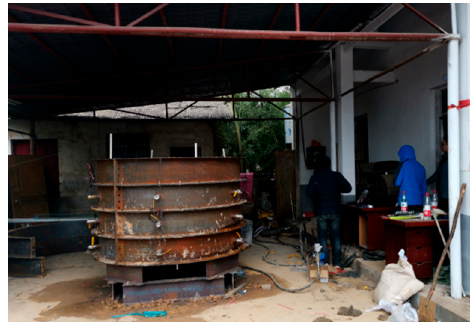
Figure 3. Test bench system.